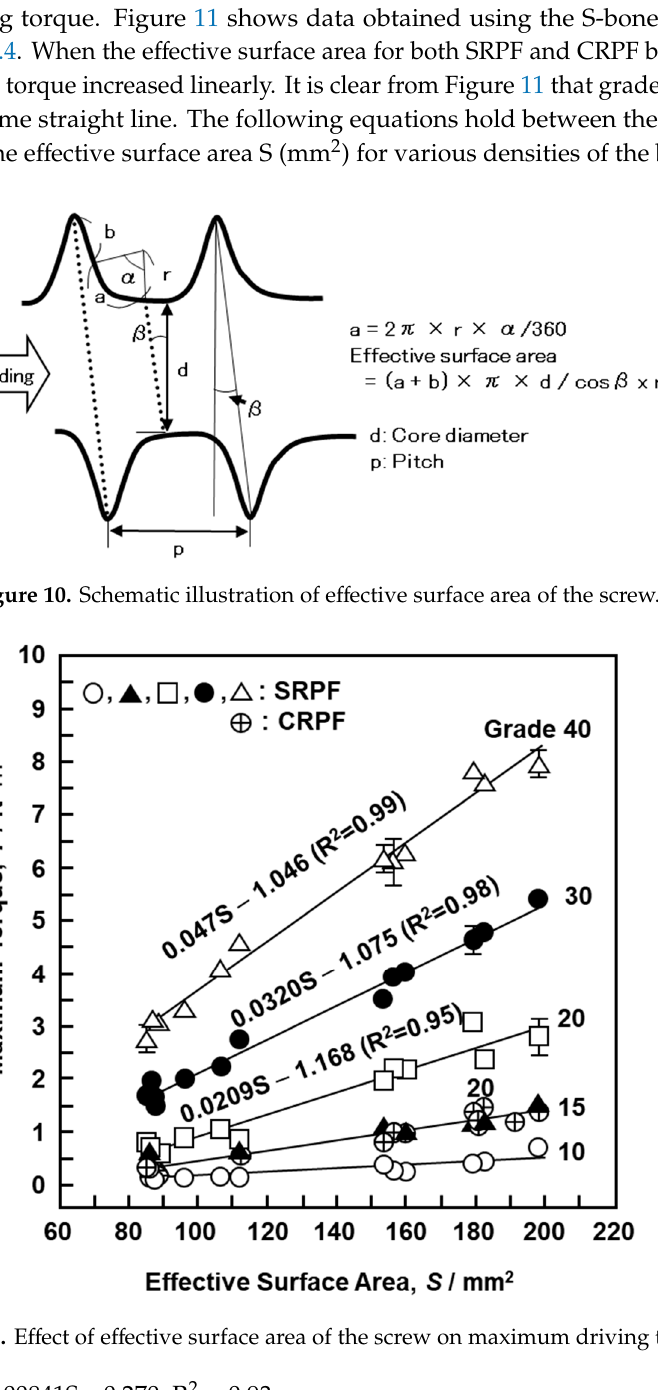
Figure 11. Effect of effective surface area of the screw on maximum driving torque.